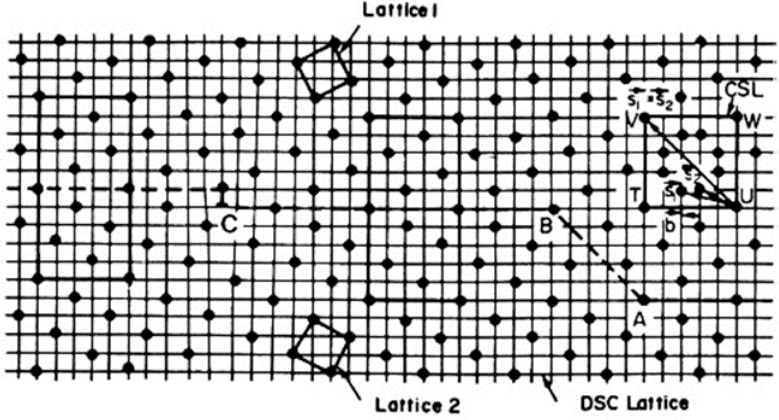
Figure 3. An illustration of CSL lattice and DSC lattice in a grain boundary with CSL lattices of Σ = 5 by a 36.9° rotation around [001] direction. (Reprinted from Reference [65], with permission from Elsevier).